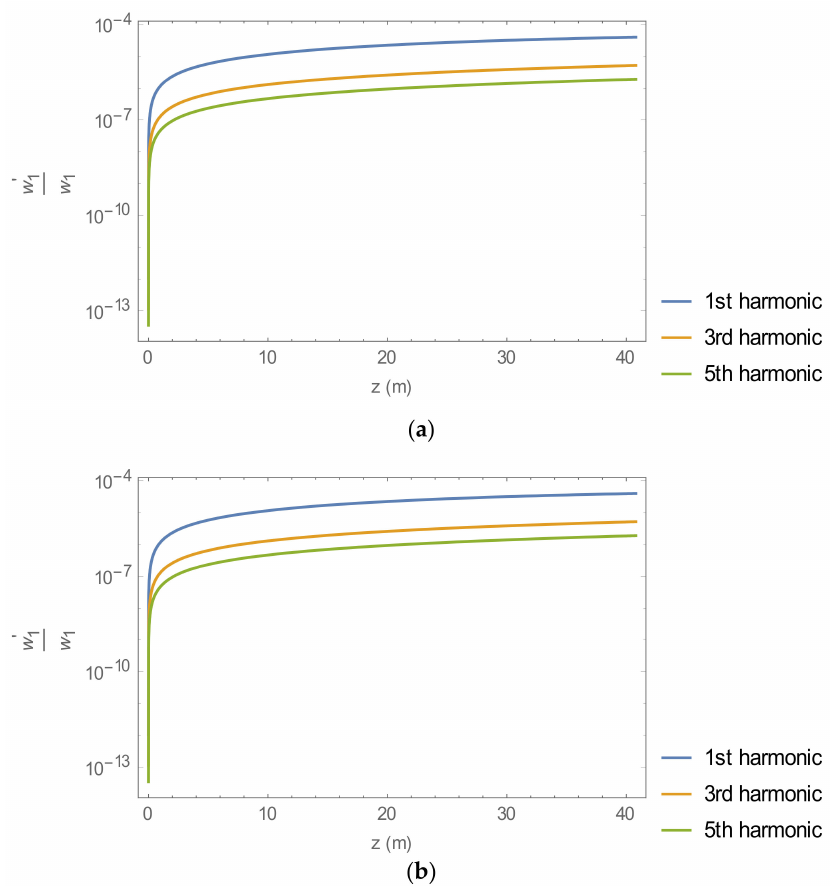
Figure 1. The ratio of the derivative of the spot size and the spot size of two beams ( a ) and a single beam ( b ) for each higher-order mode of h = 1, 3, and 5